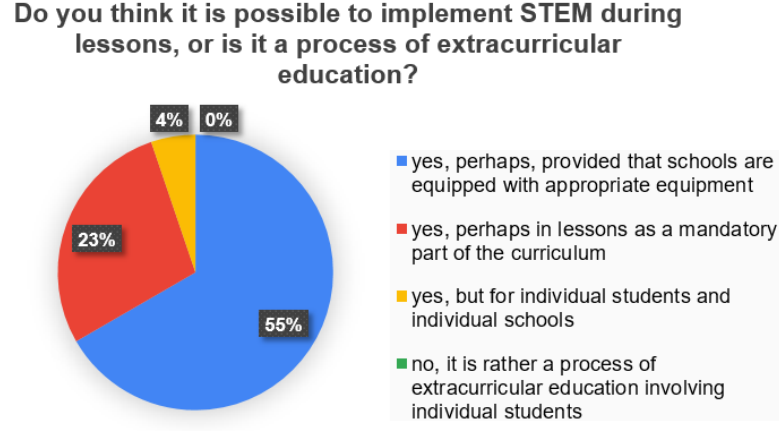
Figure 4: The results of the survey on the possibility of implementing STEM in lessons.